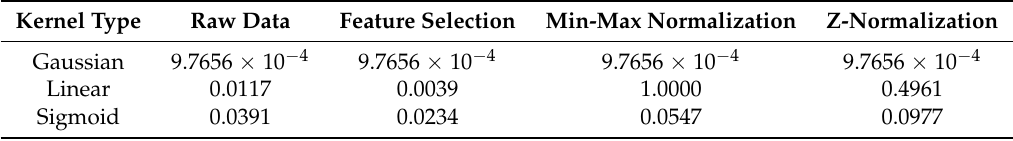
Table 7. Wilcoxon signed rank test for the prediction